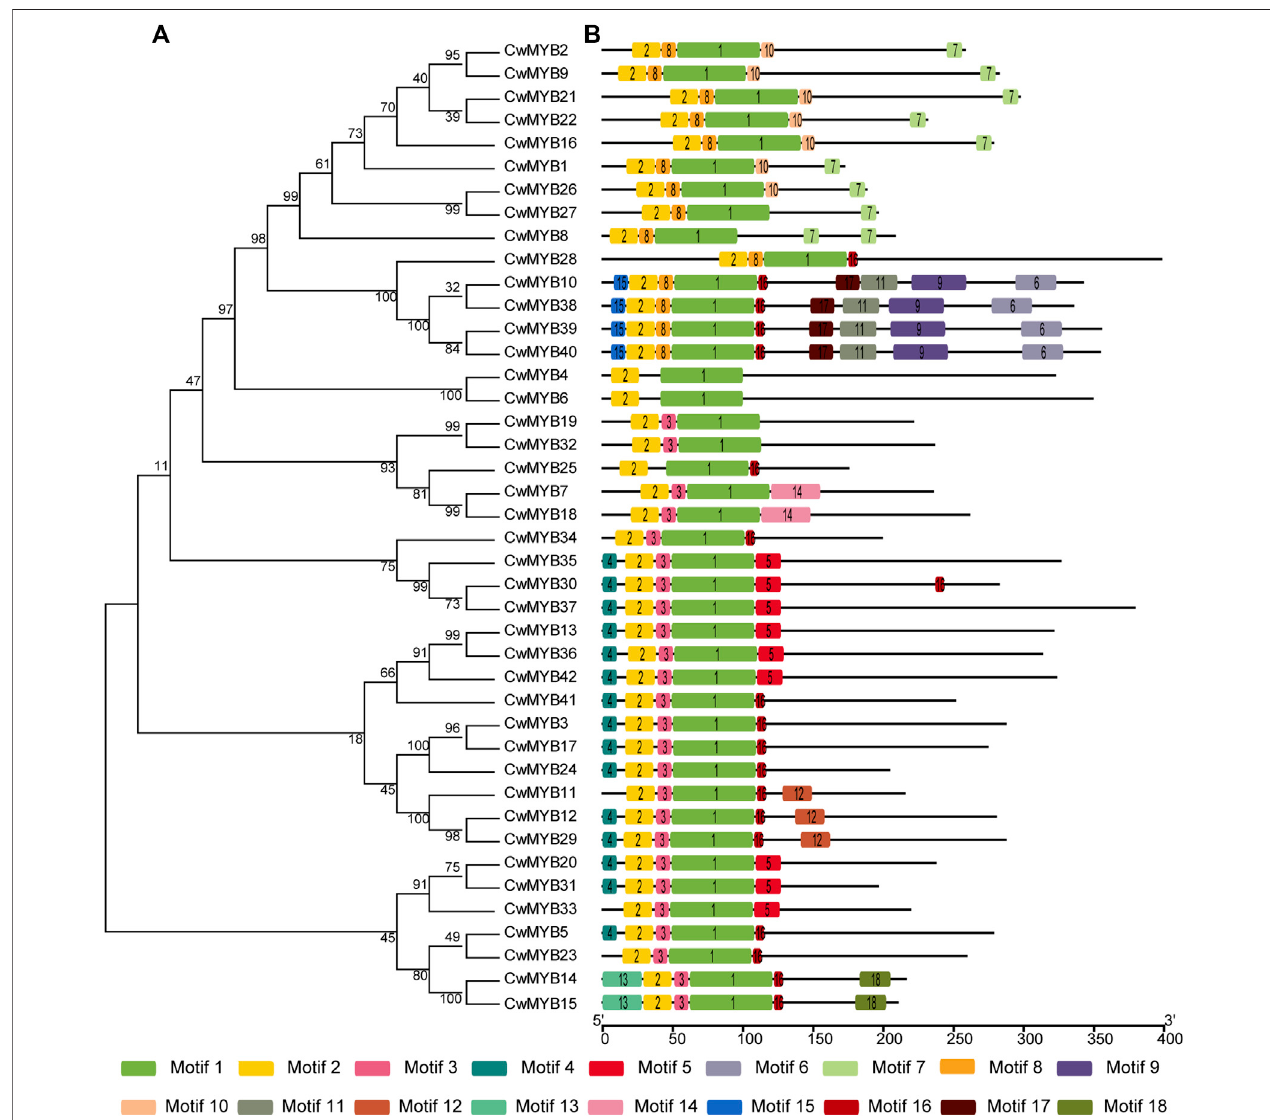
FIGURE3| PhylogenetictreeandmotifcompositionsofR2R3typeCwMYB1-42 proteinsin C.wenyujin . (A) AphylogenetictreeofCwMYB1-42 wasconstructed using MEGA 7 software coupled with the Neighbor-Joining method with a bootstrap of 1,000 replicates. (B) Schematic diagrams ofmotifcompositions. Colored boxes indicate different motifs. The picture was drawn by TB tools